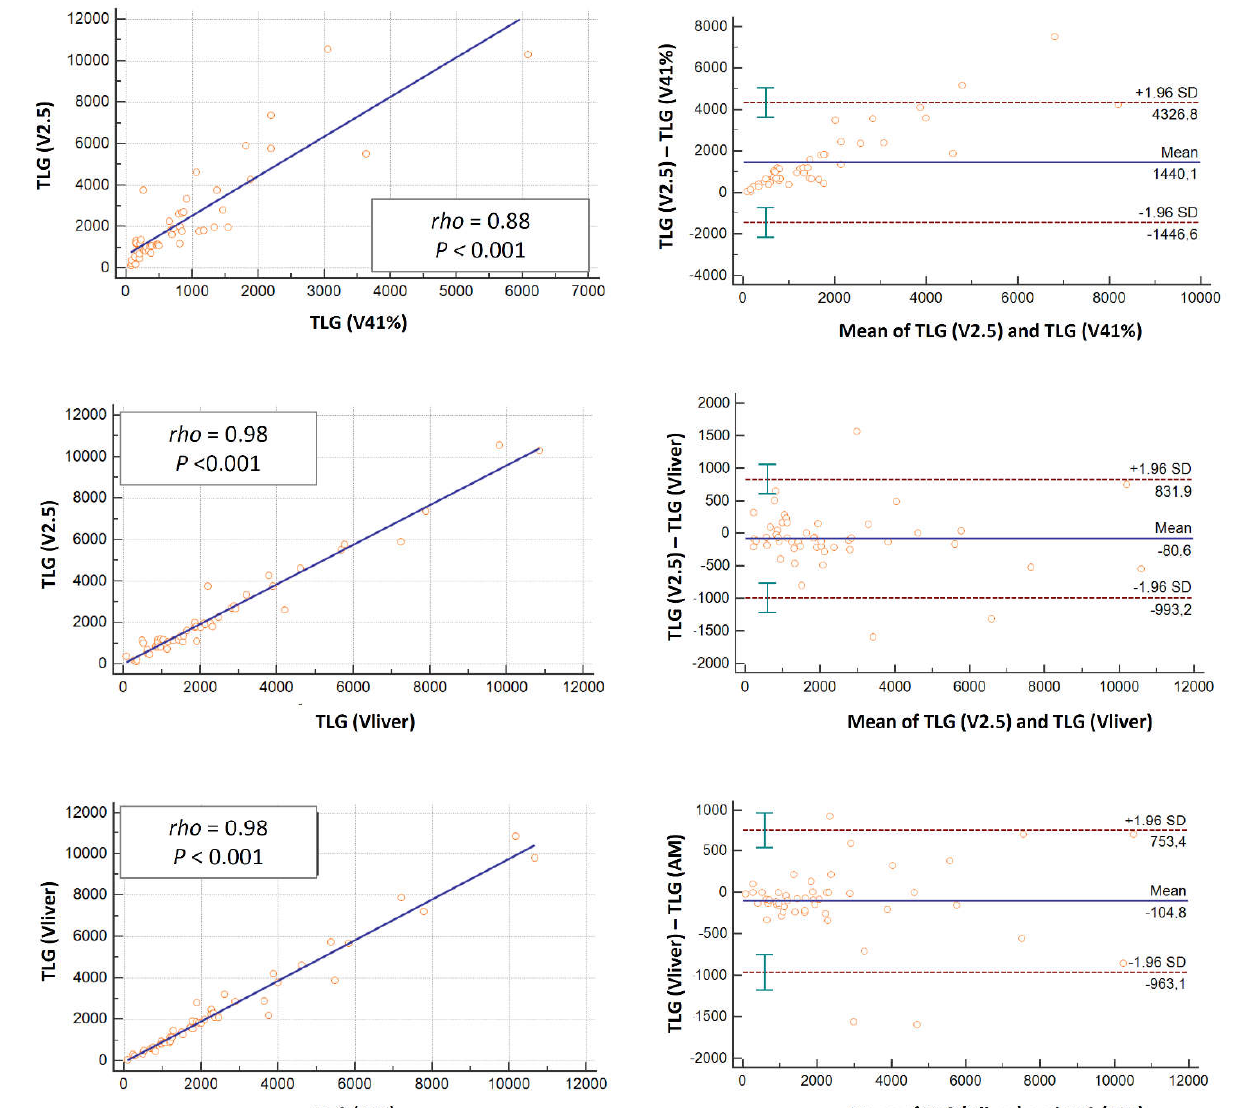
Figure 4. Scatter plots for linear regression with corresponding correlation coefficient (rho) and p -values related to the different segmentation techniques used ( left columns ); Bland-Altman plots ( right columns ) for baseline TLG values showing mean and standard deviations (SD) lines, revealing some outliners in all methods. The closer the data with respect to the mean lines and the lower the variation between SD, the high the comparability of the methods. Herein, the calculated limits of agreement are substantial especially for the V41% method..